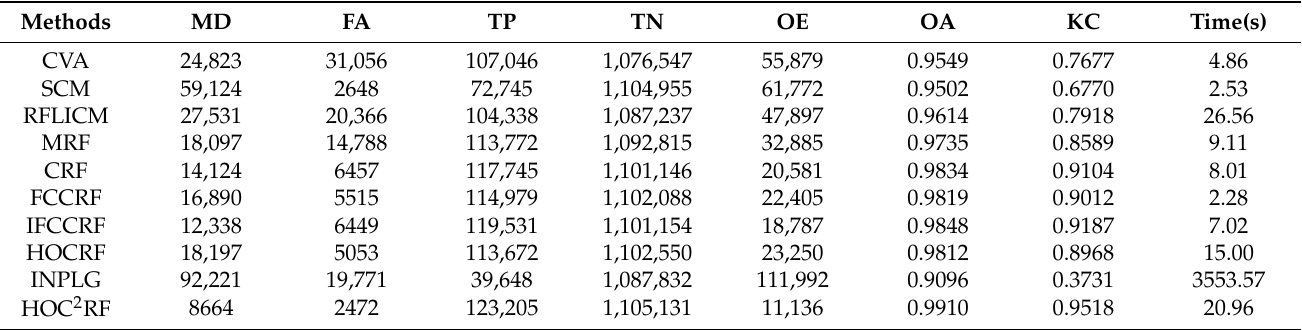
Table 4. Quantitative indicators for CD maps on the Texas dataset.